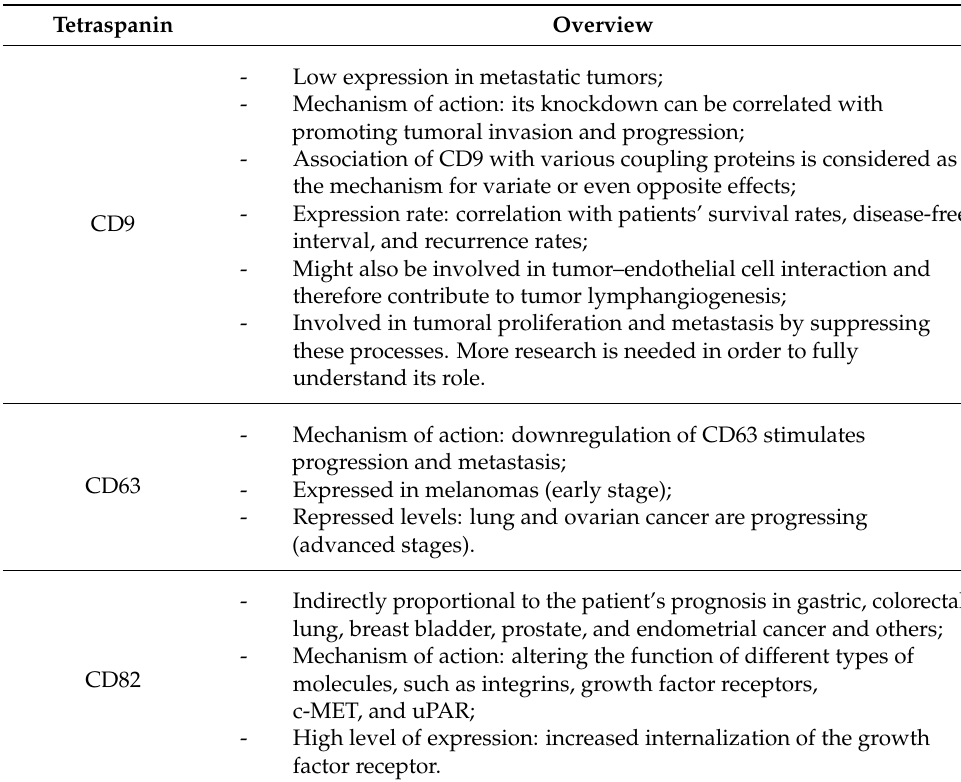
Table 3. Summary of tumor progression-suppressing